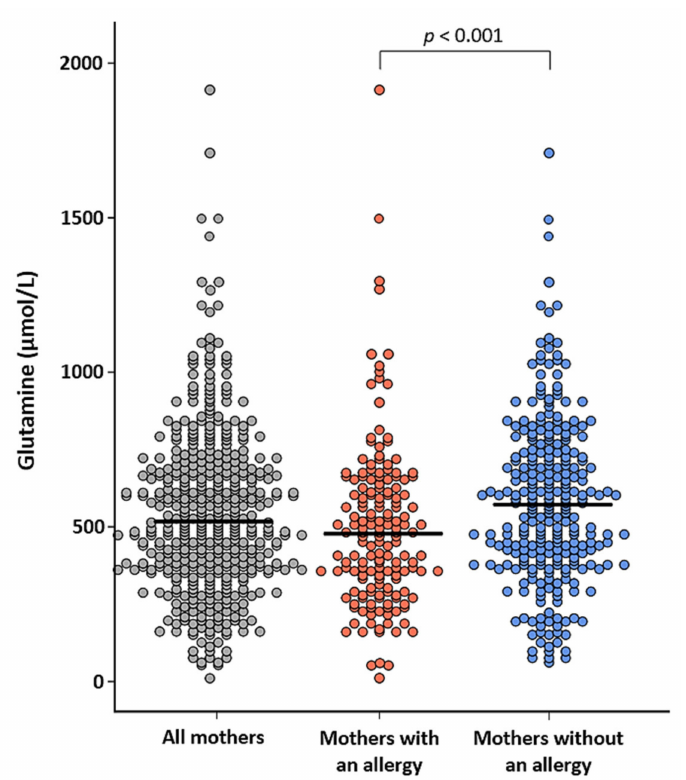
Figure 5. Levels of free glutamine in 6-month human milk samples from all mothers ( n = 441) who provided a human milk sample and from mothers with ( n = 166) or without ( n = 274) an allergy (either active or